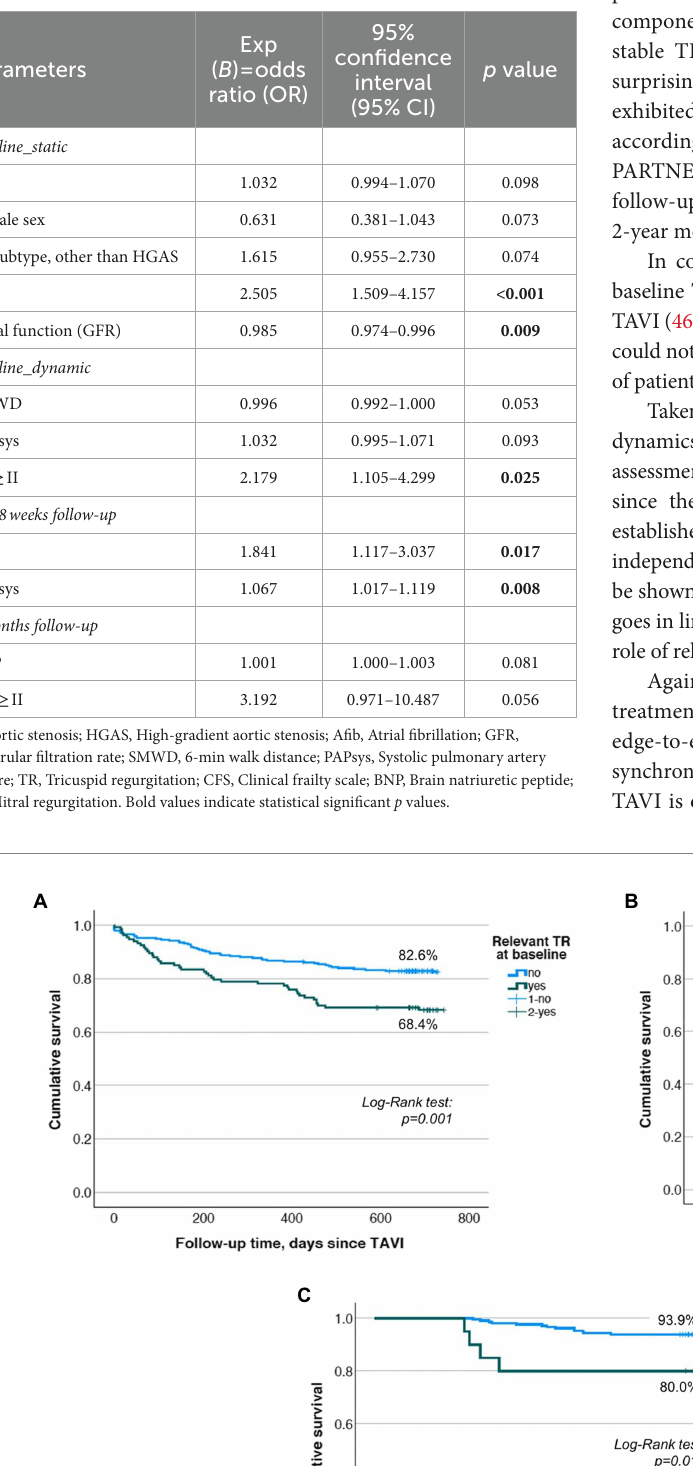
TABLE 3 Risk predictors of long-term (2-year)